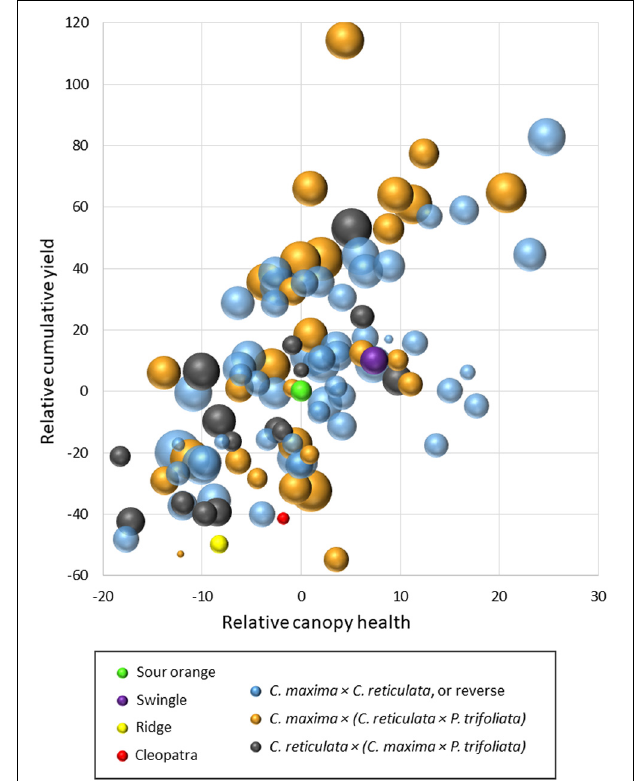
FIGURE 3 | Comparison of cumulative yield, canopy health, and yield efficiency (bubble size) for 97 new SuperSour hybrid rootstocks relative to standard sour orange rootstock and three other commercial rootstocks in two trials with Valencia scion, planted in 2014 and